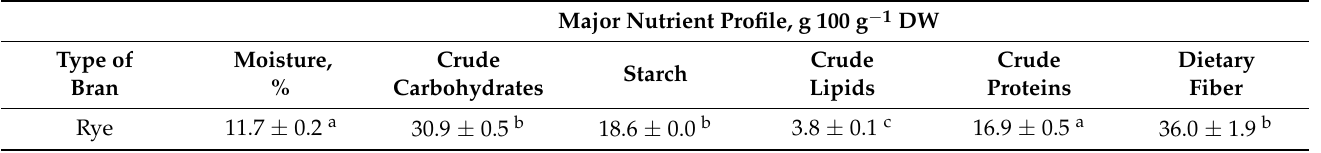
Table 1. Nutritional compositions of cereal bran by-product derived from rye grains, g 100 g − 1